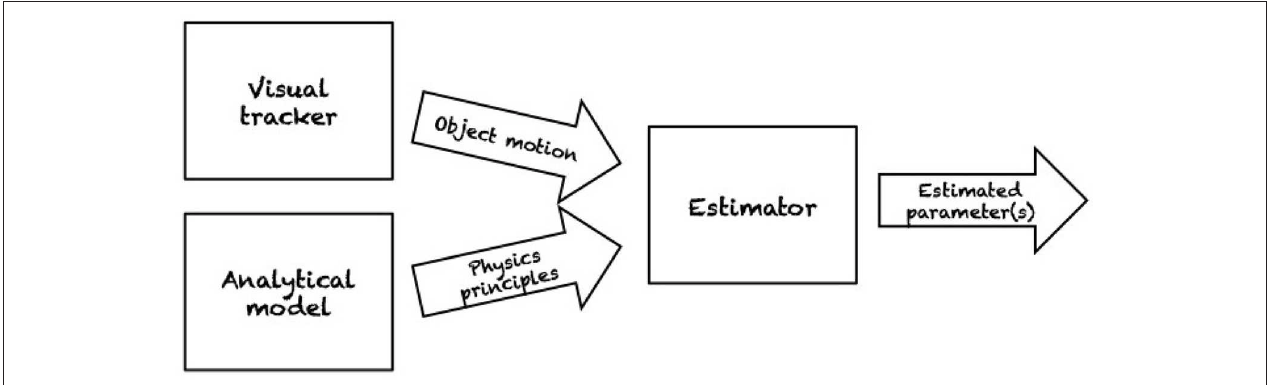
FIGURE 5 | A classical workflow for estimating relevant physical parameters of a pushed object. A robotic pusher performs a set of push operation on an object which is typically tracked using vision. Simpler approach employs markers on the object for more accurate estimations. An analytical model of the motion for the target object is also employed. Sensory data and physical principles are the inputs of the estimator. As output, the estimator provides with an estimate of the desired parameters, e.g., friction distribution or center of mass. In Lynch (1993) the estimated parameters are also used for recognizing objects based on their (estimated) physical